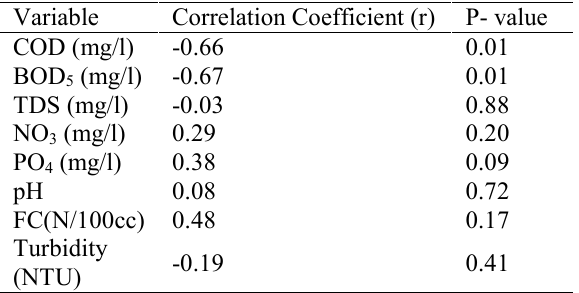
3. Pearson’s Correlation-Coefficients